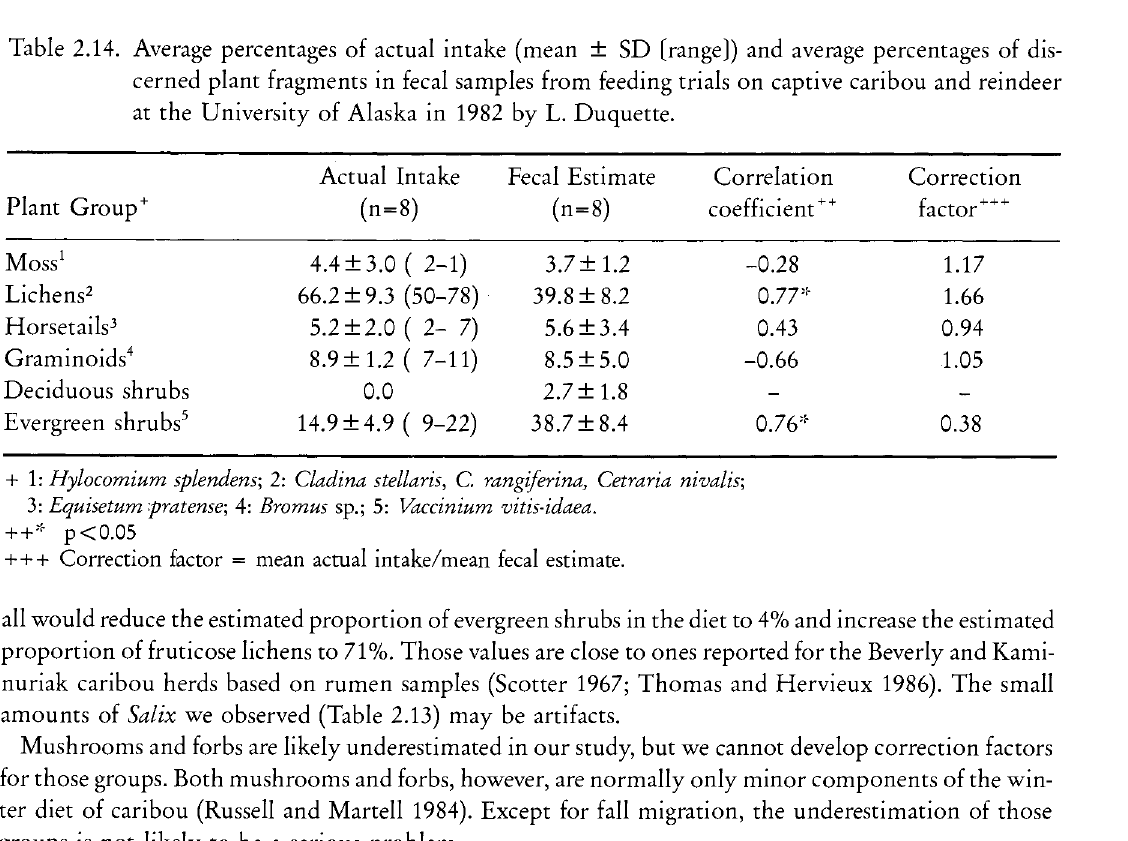
Table 2.14. Average percentages of actual intake (mean ± SD [range]) and average percentages of dis cerned plant fragments in fecal samples from feeding trials on captive caribou and reindeer at the University of Alaska in 1982 by L.